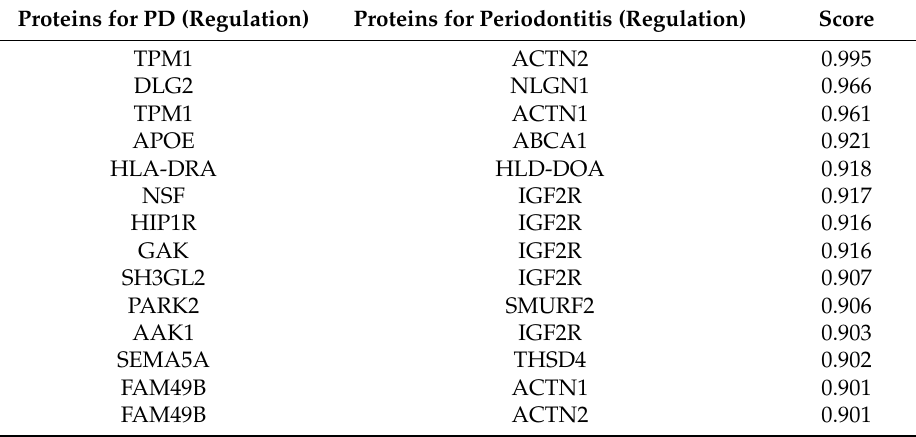
Table 1. Score results between Parkinson’s disease (PD) and periodontitis related proteins identified in the network interaction. Proteins for PD (Regulation) Proteins for Periodontitis